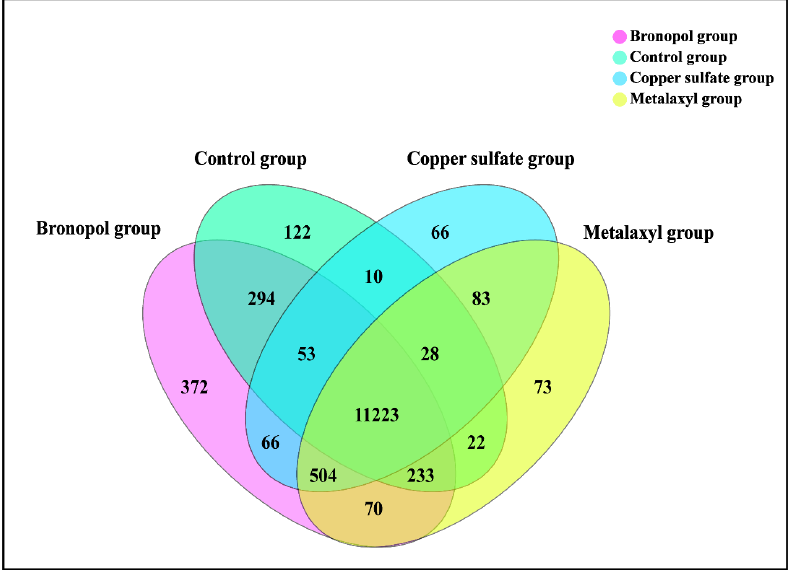
Figure 1. Venn diagram of expressed genes in Saprolegnia parasitica following treatment with met- alaxyl, bronopol and copper sulfate at MICs.